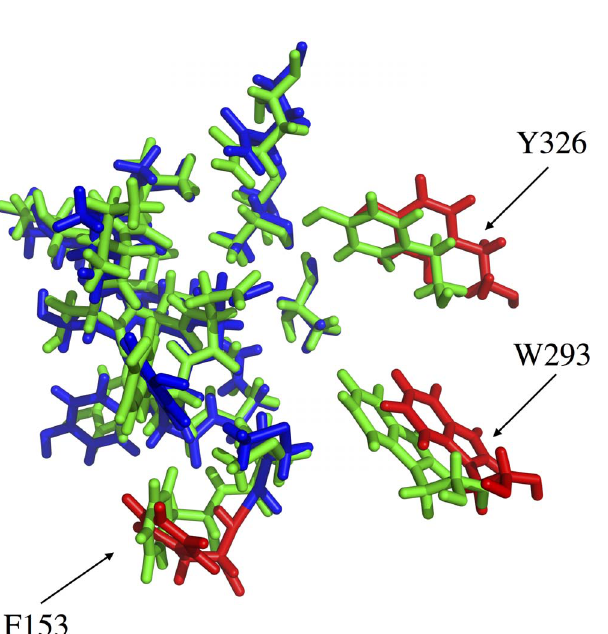
Fig. 7. Superimposition of the binding site conformations observed at the 270 th (green) and 375 th (blue) ns frames, i.e. , the frames of the minimum and maximum POCASA volume, respectively, as deserved during the 0.5 m s all-atom MD simulation of the m OR structure. The three residues labelled, i.e ., F153, W293, and Y326, are the only ones located in the minimum volume pocket. The corresponding residues of the binding site conformation related to the maximum POCASA volume are presented in